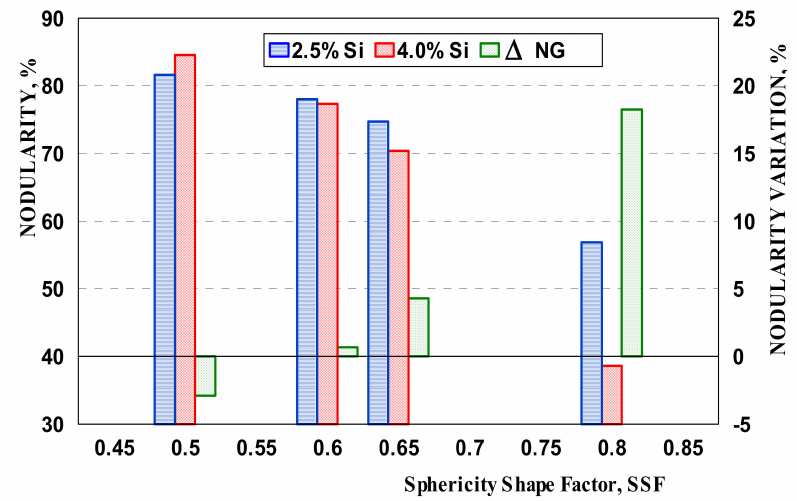
Figure 6. Influence of silicon (Si) content and minimum sphericity shape factor (SSF) on the graphite nodularity level and the di ff erence ( ∆ NG) in graphite nodularity between 2.5%Si and 4%Si content ductile cast